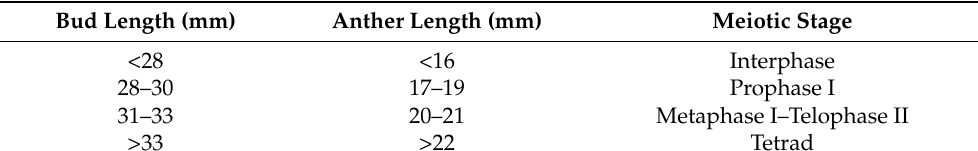
Figure 1. Meiotic processes of PMCs of ‘Black Beauty’. ( a ) Interphase. ( b ) Prophase I. ( c ) Metaphase I. ( d ) Anaphase I. ( e ) Telophase I. ( f ) Prophase II. ( g ) Metaphase II. ( h ) Anaphase II. ( i ) Telophase II. ( j ) Tetrad.